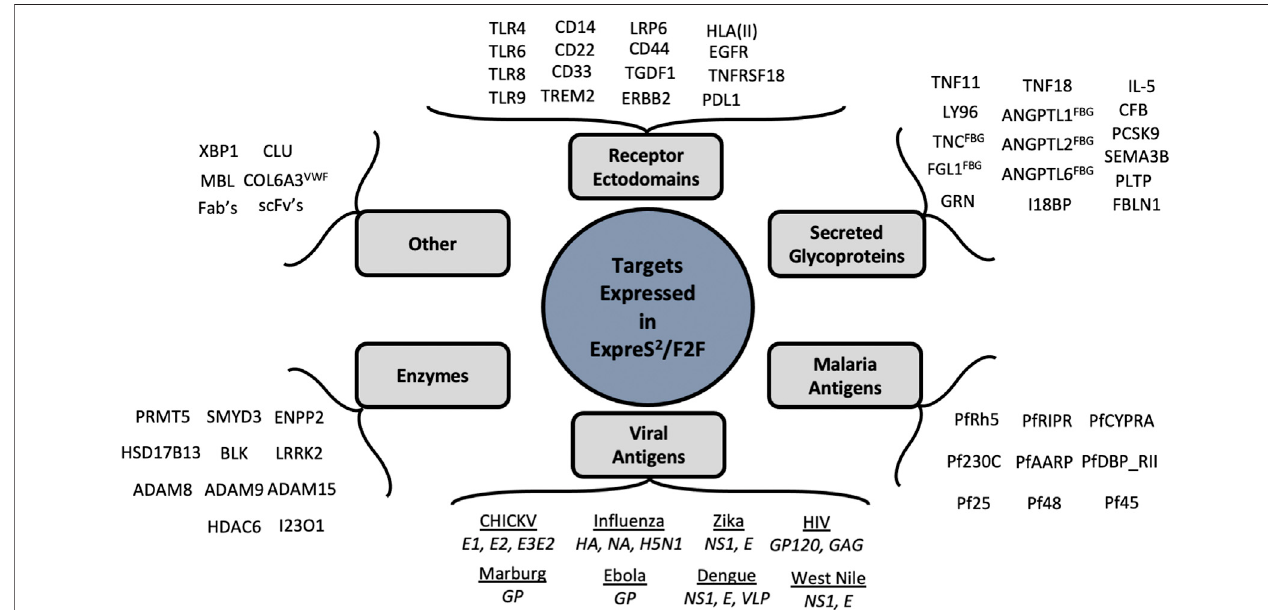
FIGURE 6 | Diverse targets expressed in S2Cells. Representative examples ofproteinsexpressed with the ExpreS 2 /F2F system both in-house and at ExpreS 2 ion Biotechnologies.